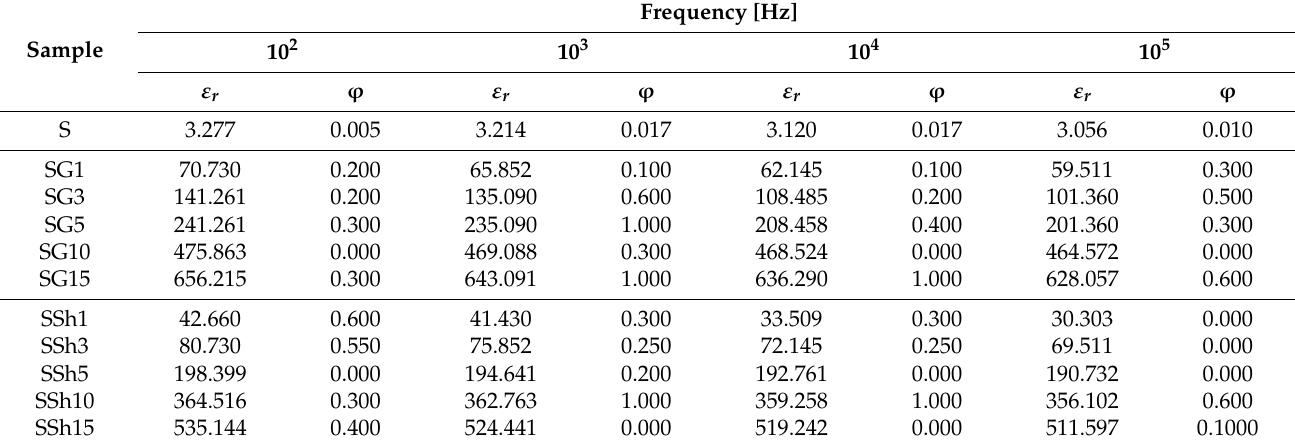
ε r —dielectric constant. ϕ —dielectric